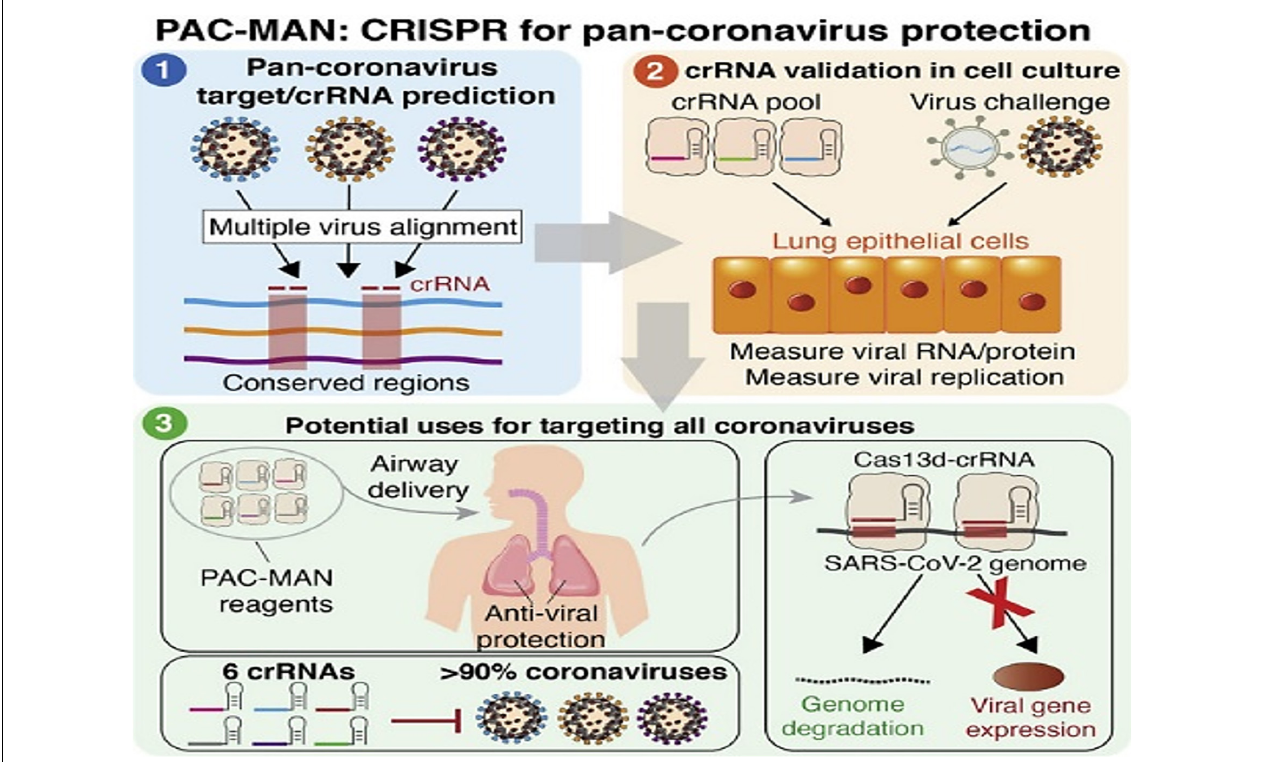
FIGURE 2 | Highlights of PAC-MAN based strategy to target conserved sequences across coronaviruses and other pathogenic viruses (Reproduced from Abbott et al., 2020, based on the reuse-provisions of Elsevier’s COVID-19 Resource Centre, Copyright© 2020 Elsevier,